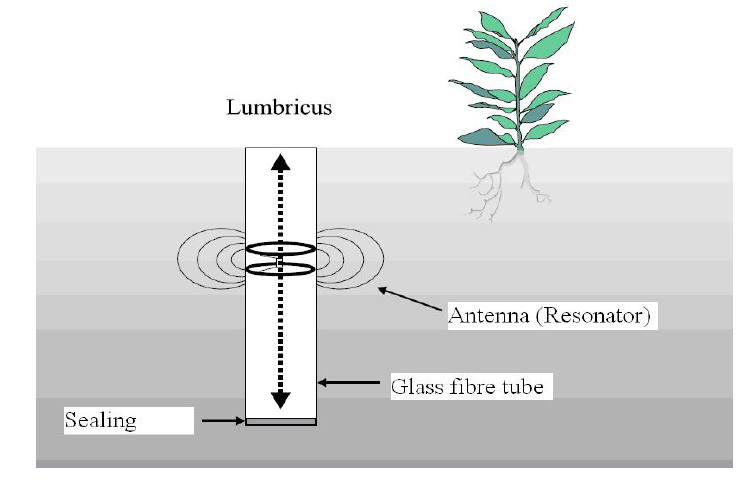
Figure 1. ‘LUMBRICUS’ FD sensor with antenna, access tube and sealing.